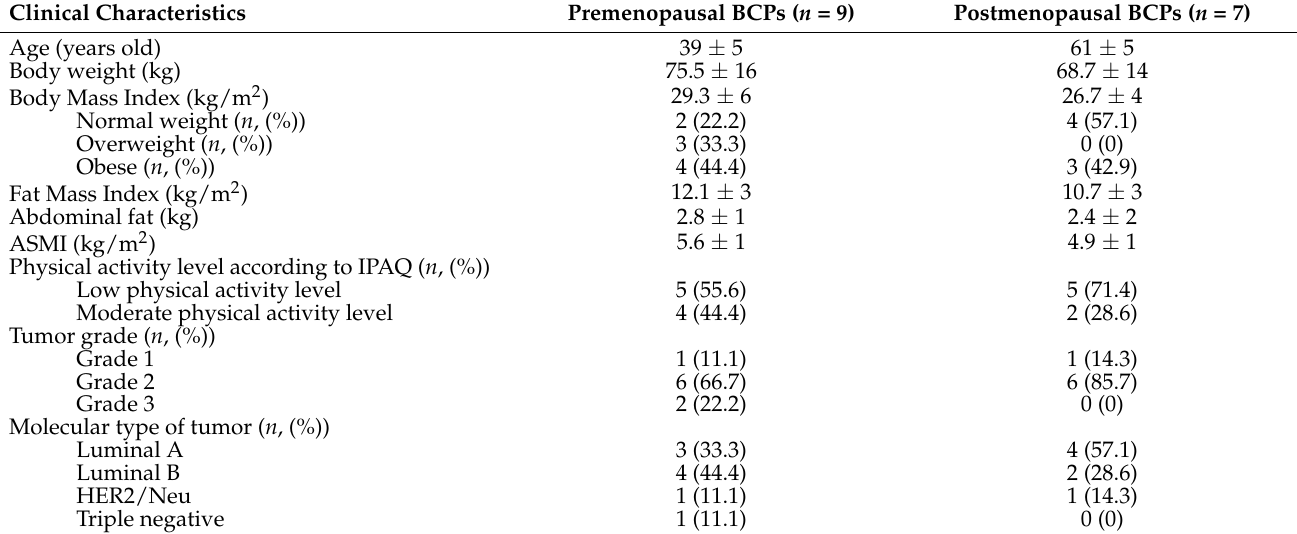
Table 1. Clinical characteristics of the breast cancer patients admitted to the subsample analyses.